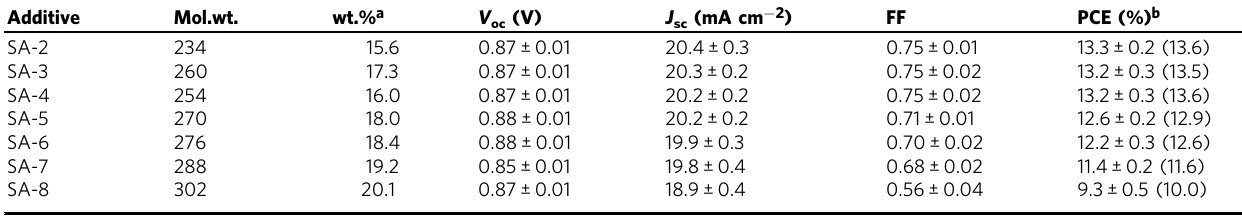
Table 2 Photovoltaic parameters for PBDB-TF:IT-4F based devices with different SAs incorporated into the casting solution Additive Mol.wt.